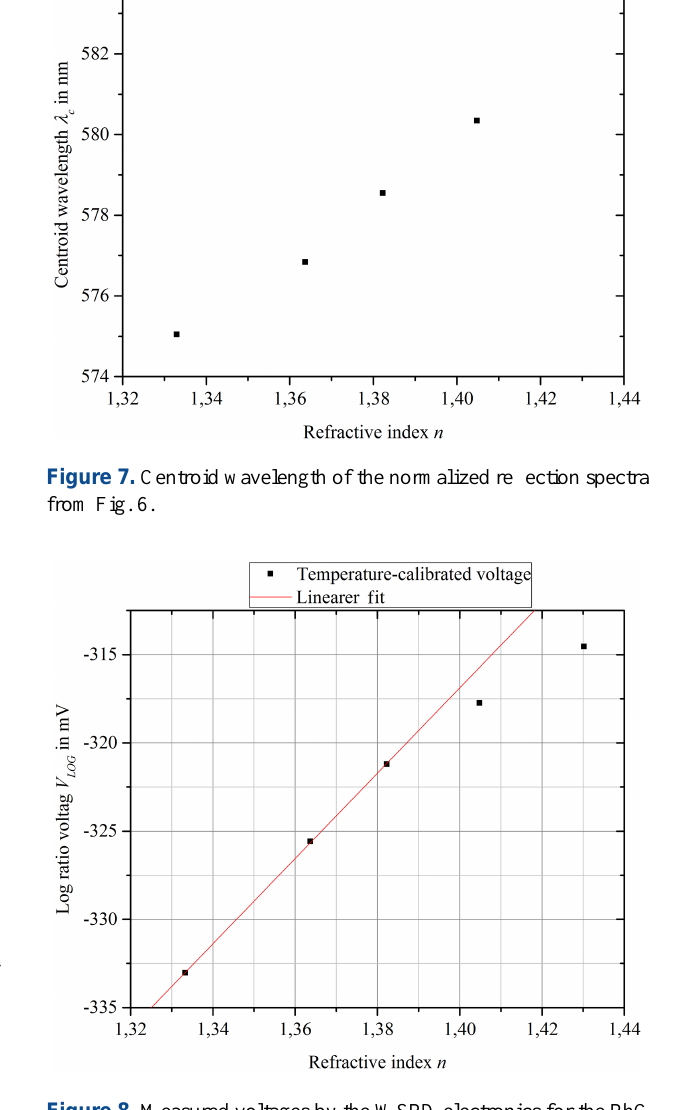
Figure 8. Measured voltages by the WSPD electronics for the PhC reflection spectra at different refractive indexes (Fig.